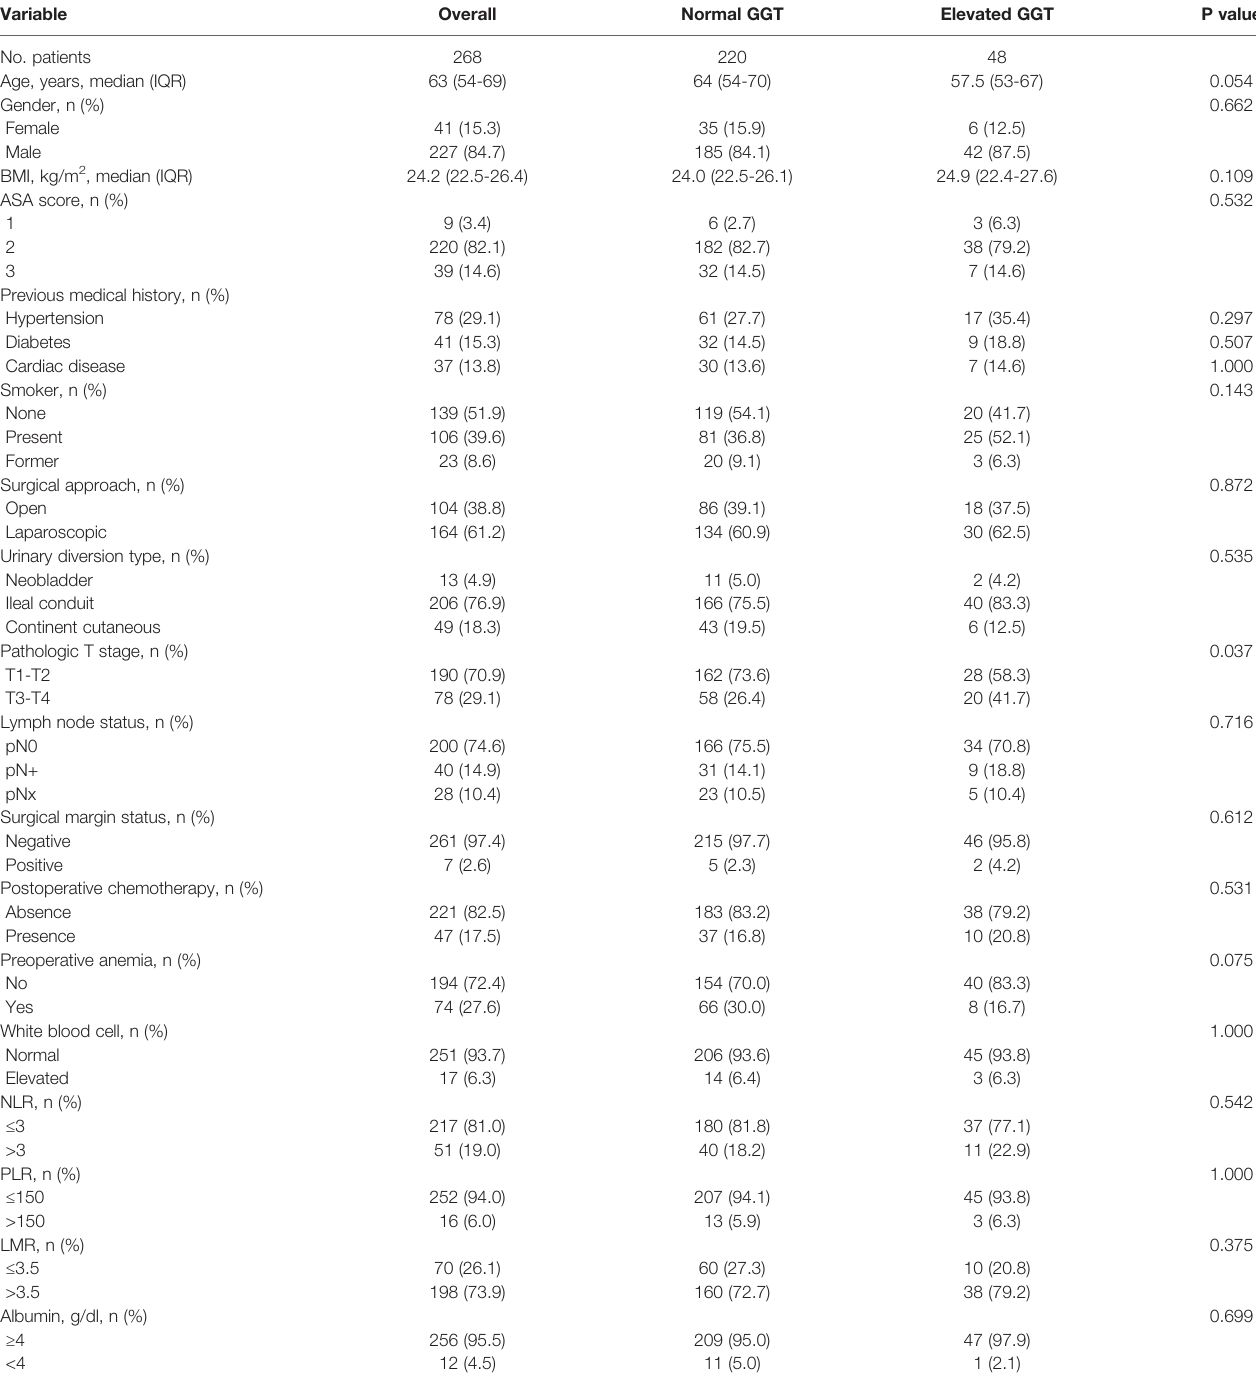
TABLE 1 | Baseline characteristics of patients undergoing radical cystectomy for bladder